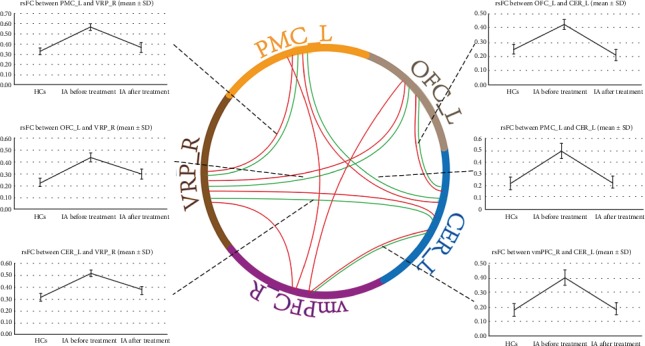
ROI-to-ROI rsFC analysis between IA subjects and HCs at baseline and between pre- and posttreatment in IA individuals. (1) Red solid line: compared with HCs, IA adolescents exhibited increased rsFC of the right VRP with the left PMC, OFC, cerebellum, and right vmPFC, as well as enhanced rsFC of the left cerebellum with the left PMC, OFC, and right vmPFC at baseline. Higher rsFC of the right vmPFC with the left OFC and PMC were also observed. (2) Blue solid line: after treatment, the rsFC of the right VRP with the left PMC, OFC, and cerebellum in IA subjects were reduced, as well as the rsFC of the left cerebellum with the left PMC, OFC, and right vmPFC. rsFC: resting-state functional connectivity; IA: Internet addiction; HCs: healthy control subjects; L: left; R: right; VRP: ventral rostral putamen; PMC: premotor cortex; OFC: orbitofrontal cortex; vmPFC: ventromedial prefrontal cortex; CER: cerebellum.